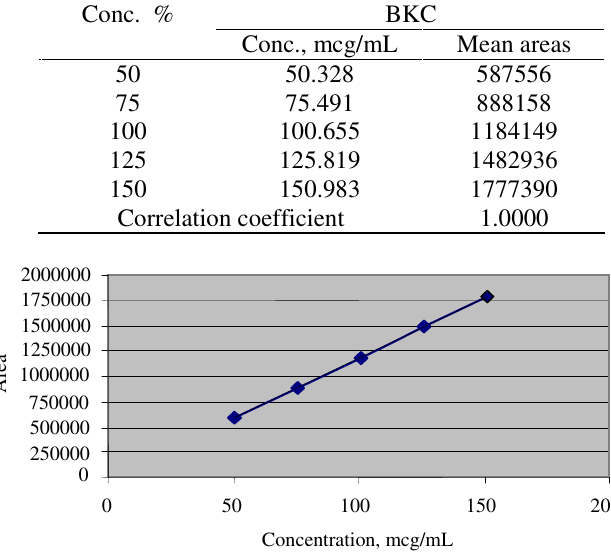
Figure 3. Linearity curve of preservative analogue benzalkonium chloride